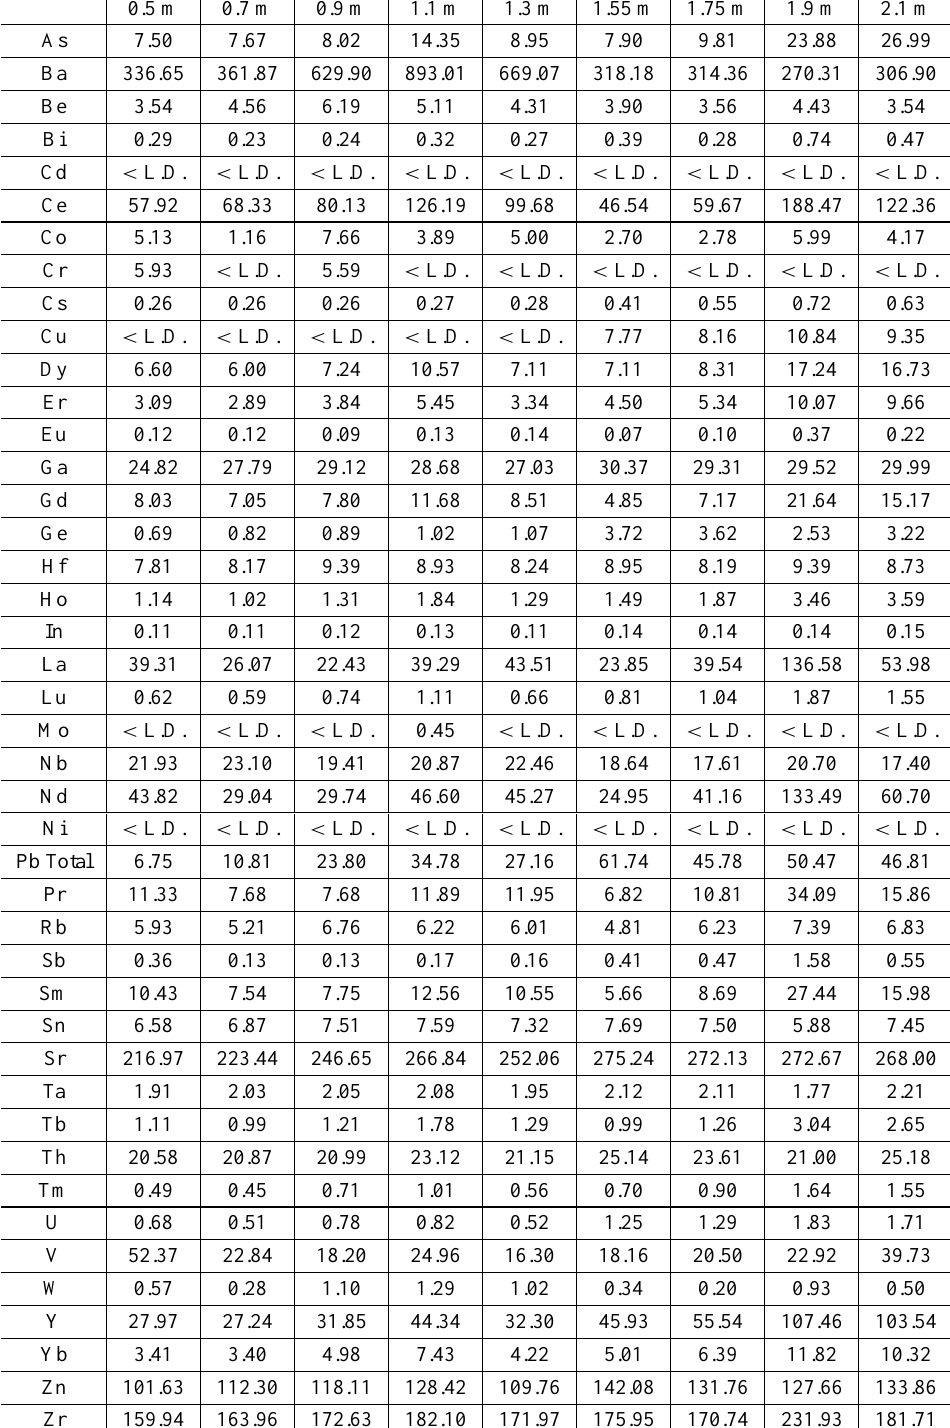
Trace element abundances (ppm) of samples from the massive bentonite